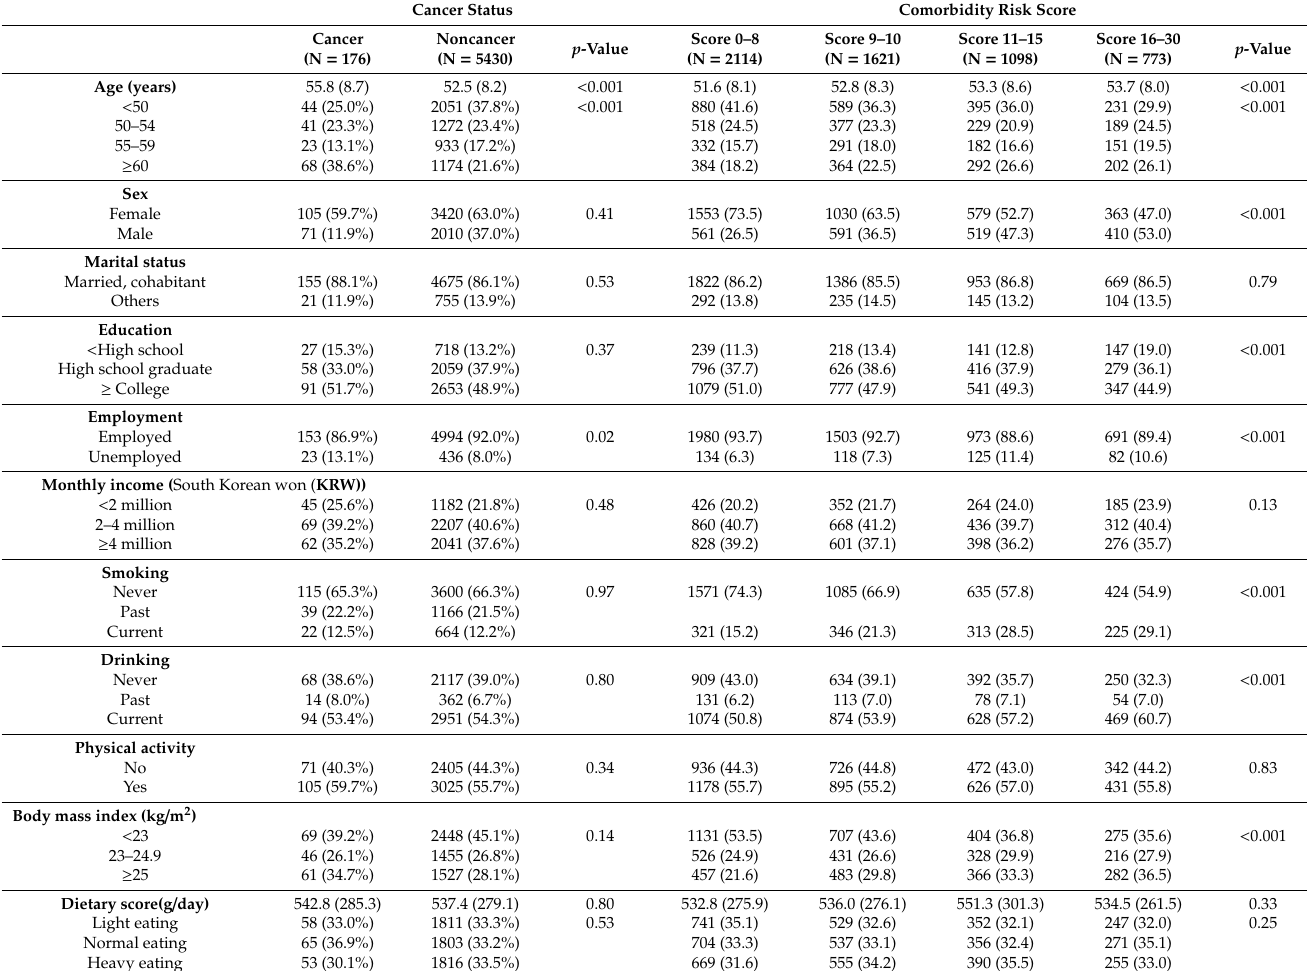
Table 4. Baseline characteristics of the study